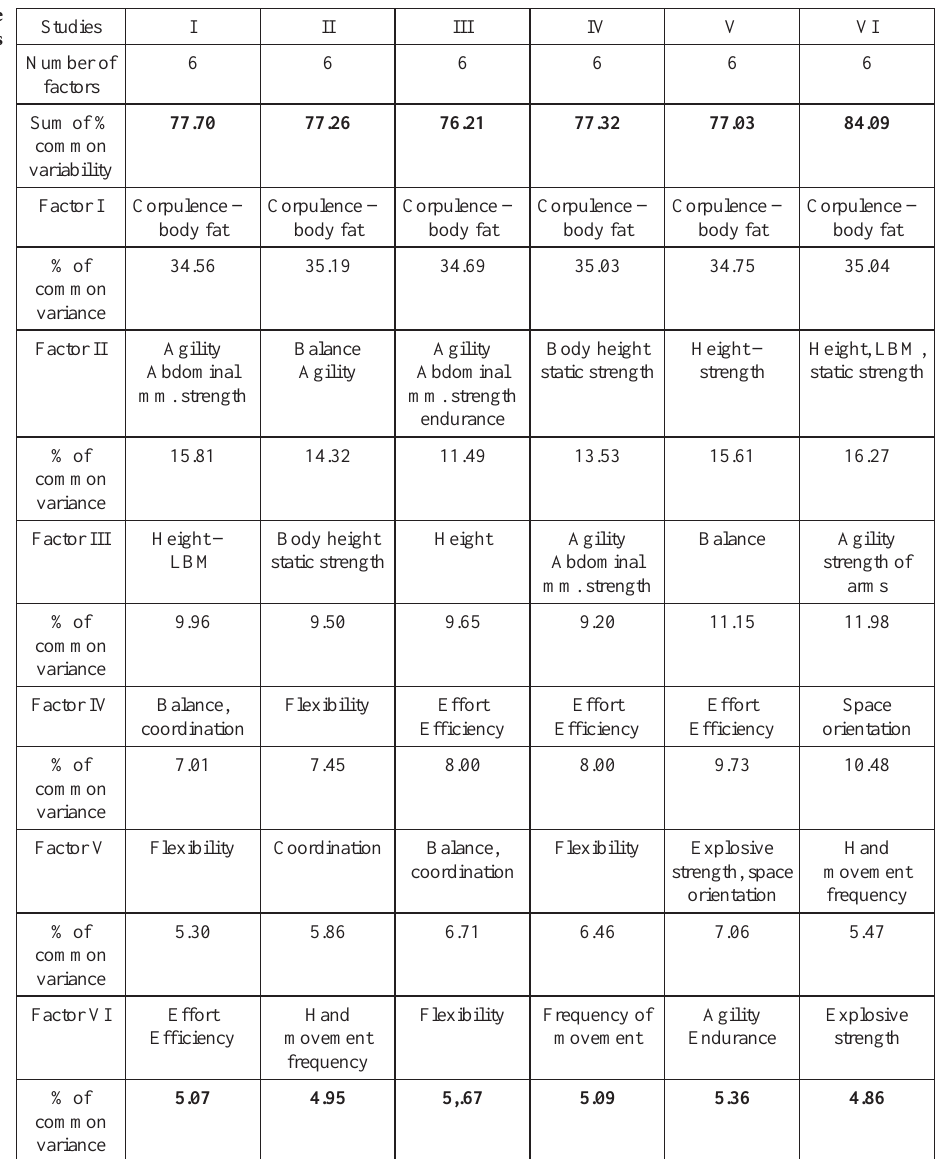
Table 4. Identifi cation of the results of the factor analysis in the training